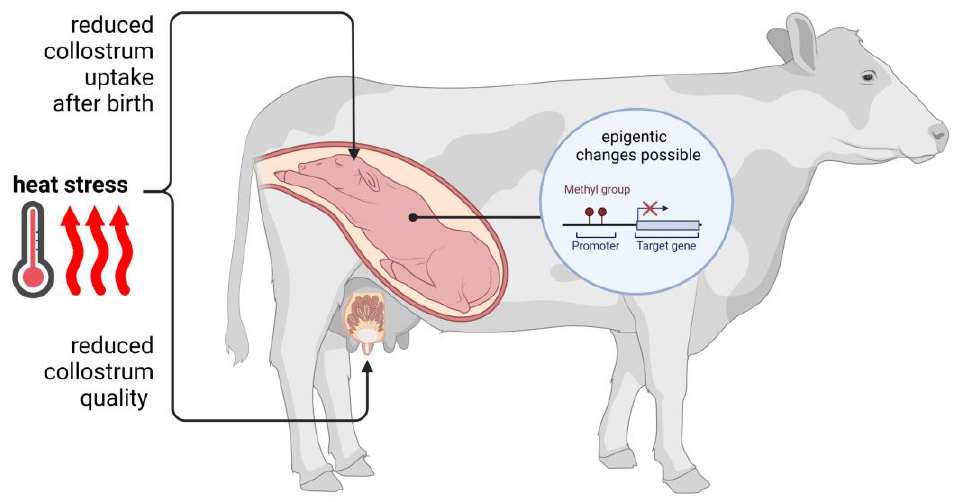
Figure 3. Scheme showing the impact of heat stress on developing fetus (calf) and on the mammary gland during bovine pregnancy.